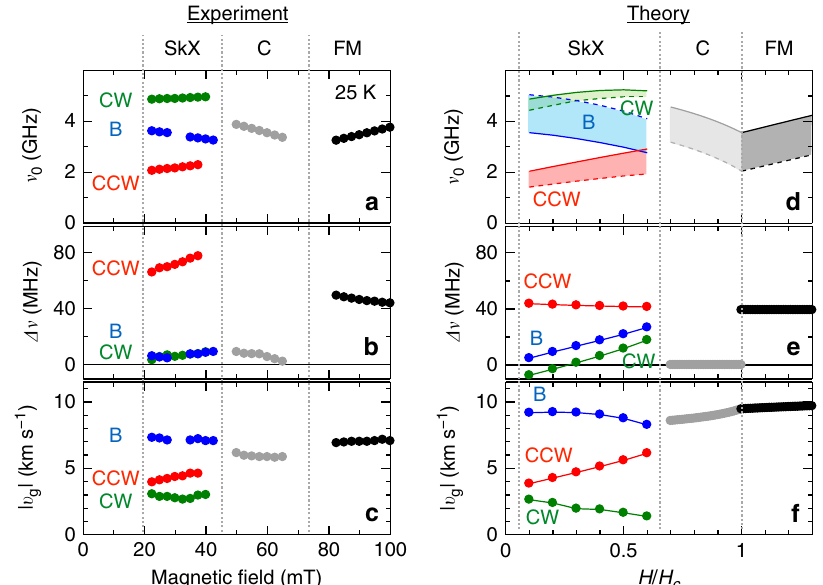
Fig. 3 Magnetic fi eld dependence of propagation character for various spin excitation modes. a – c Experimentally obtained magnetic fi eld dependence of ( a ) magnetic resonance frequency ν 0 , ( b ) frequency shift Δν between ± k SW , and ( c ) magnitude of group velocity ∣ v g ∣ at 25 K. It is noteworthy that the data for the conical spin state is taken in the H -increasing run after the zero fi eld cooling (Supplementary Fig. 1). d – f The corresponding data calculated from the theoretical dispersion relation. In d , the k SW → 0 values in the bulk and magnetostatic limit are plotted as dashed and solid lines, respectively, whose difference δν d provides an estimate of the group velocity v g ≈ 2 π b ( δν d ) shown in f with b being the sample thickness. In e , the non-reciprocal frequency shift Δν is shown computed for ∣ k SW ∣ = 0.5 μ m − 1